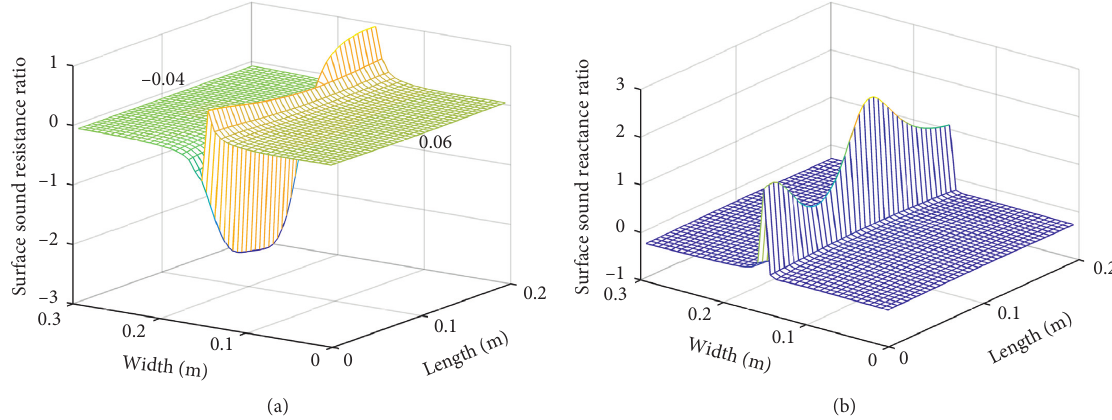
Figure 6: Surface sound impedance ratio of the active MPPA on the resonant frequency of the (1, 2) mode after control: (a) sound resistance ratio and (b) sound reactance ratio.